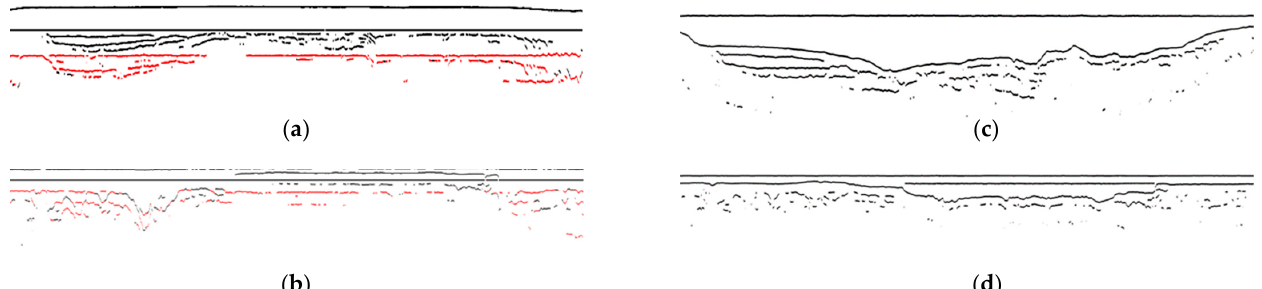
Figure 17. Distinguishing between horizons and multiples. ( a ) (SBL_20120628_085229) and ( b ) (SBL_20160305_025613) are the transformed images by pseudo-Radon transform. The red lines are the identified multiples; the black lines are horizons. ( c ) (SBL_20120628_085229) and ( d ) (SBL_20160305_025613) are the inverse pseudo-Radon transformed images after multiples removal.